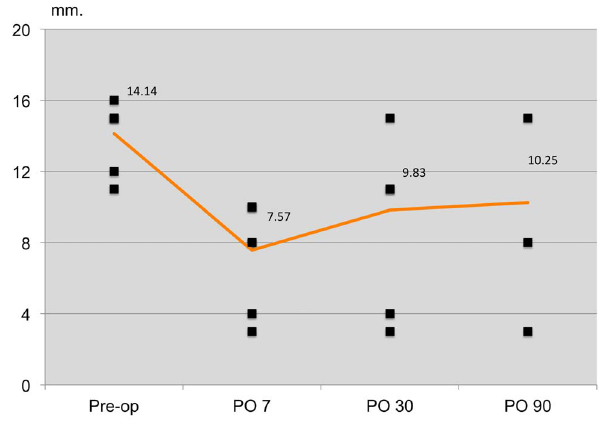
Figure 5. Pattern of post-operative dry eye patients detected by Schirmer I without anesthesia. The patterns of dry eye were similar between 3 clinical tests with OSDI questionnaire.